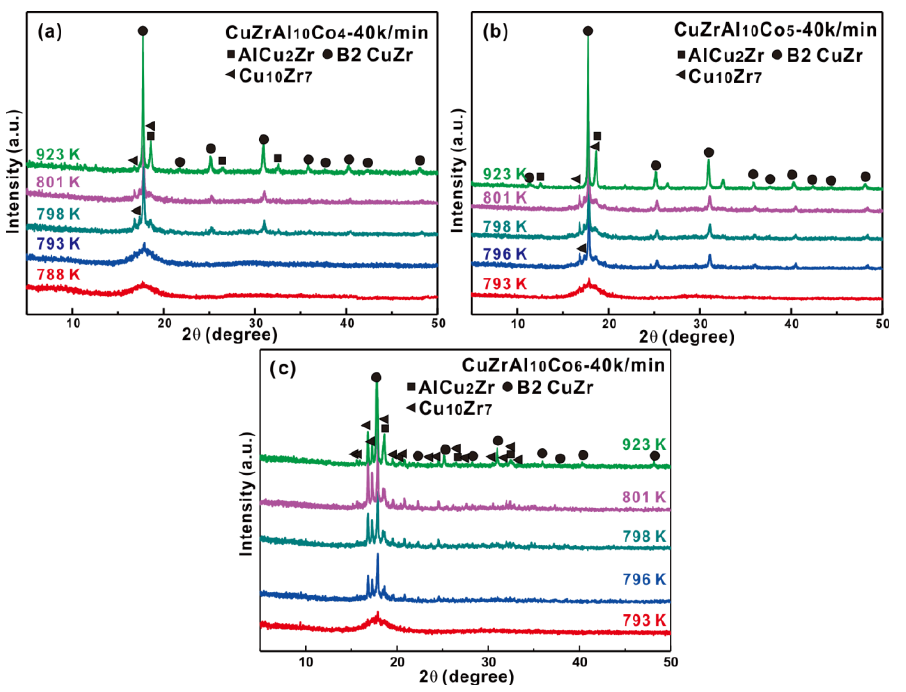
Figure 2. XRD patterns of the as-annealed (Cu 0.5 Zr 0.5 ) 90-x Al 10 Co x (x = ( a ) 4, ( b ) 5, and ( c ) 6 at. %) samples at a heating rate of 40 K/min at temperatures as indexed in the present figures.